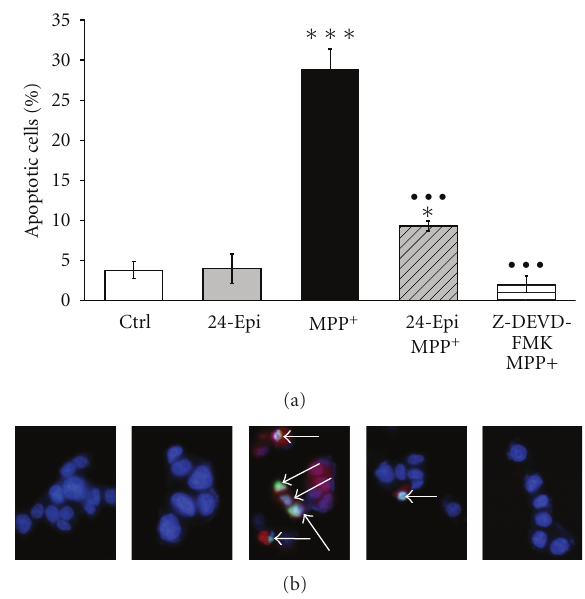
Figure 7: (a) Histogram showing the percentage of apoptotic cells counted on triple-stained slides (merged), as described in Materials and Methods. To illustrate that caspase-3 activation is a key step in the MPP + -induced apoptotic pathway, PC12 neuronal cells were pretreated with Z-DEVD-FMK, a cell-permeable caspase- 3 inhibitor, followed by treatment with MPP + . Pretreatment with 24-Epi strongly reduced the number of apoptotic neuronal PC12 cells induced by treatment with MPP + (24-Epi + MPP + ), and pretreatment with the caspase-3 inhibitor prevented MPP + -induced apoptosis. The data are expressed as percentages of apoptotic cells and are means ± S.E.M. n = 3. ∗ P < . 05 and ∗∗∗ P < . 001 versus Ctrl and ••• P < . 001 versus MPP + . (b) Immunofluorescence detection of apoptotic neuronal PC12 cells on triple-stained slides (merged), as described in Materials and Methods. Blue: neuronal PC12 nuclei were counterstained in blue with DAPI. Red: anticleaved caspase-3 antibody. Green: TUNEL. Merged: cells are considered apoptotic when positive for both TUNEL (green) and anticleaved caspase-3 antibody (red). They appear as light blue cells (arrows) because of the third superposition of dark blue DAPI. Triple-staining (merged) clearly reveals several apoptotic cells, indicated by arrows, on slides treated with MPP + (MPP+) and fewer apoptotic PC12 cells (arrow) when they are pretreated with 24-Epi prior to MPP +